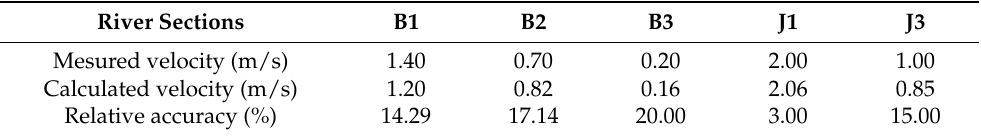
Table 4. Relative accuracy evaluation